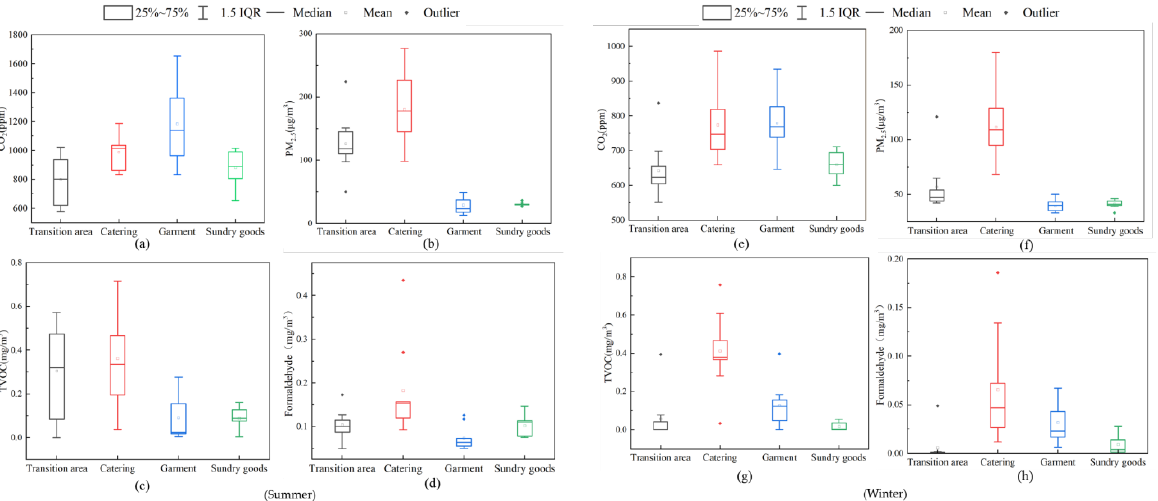
Figure 6. The indoor CO 2 ( a , e ), PM 2.5 ( b , f ), TVOC ( c , g ), and formaldehyde ( d , h ) levels of different merchandise sections. merchandise